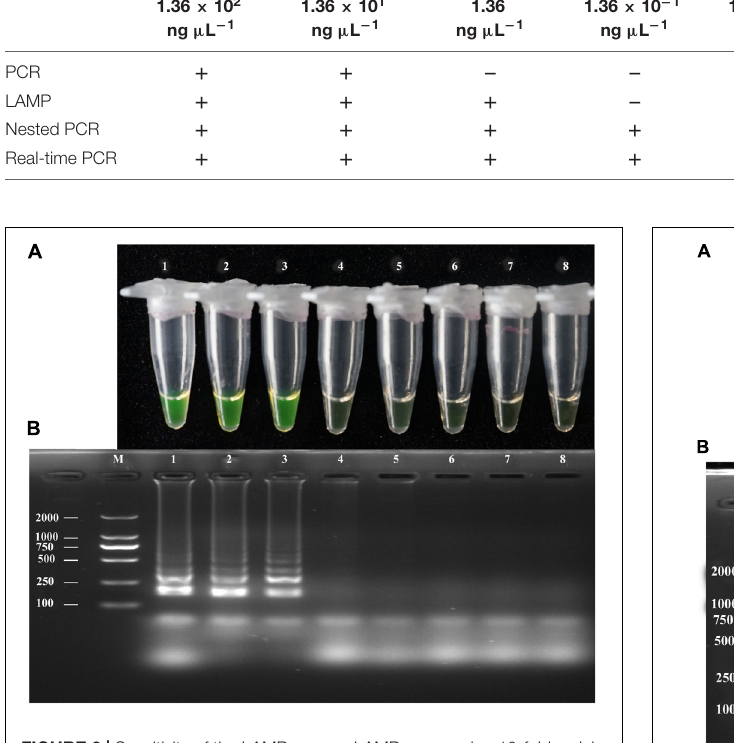
FIGURE 3 | Sensitivity of the LAMP assays. LAMP assay using 10-fold serial dilutions of purified target DNA from A. solani . (A) Detection of LAMP products by Calcein fluorescence dye. (B) Analysis of the LAMP products by agarose gel electrophoresis. Concentrations of template DNA were as follows: Lane 1: 1.36 × 10 2 ng µ L − 1 ; Lane 2: 1.36 × 10 1 ng µ L − 1 ; Lane 3: 1.36 ng µ L − 1 ; Lane 4: 1.36 × 10 − 1 ng µ L − 1 ; Lane 5: 1.36 × 10 − 2 ng µ L − 1 ;